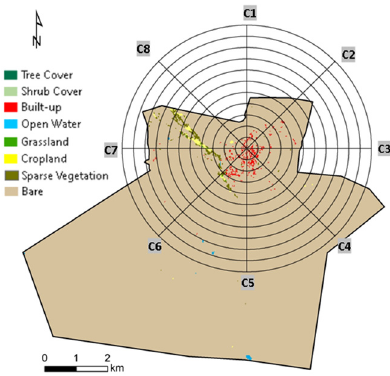
Figure 13. Land cover classification for the urban area of Smara (buffers shown every 360 m).